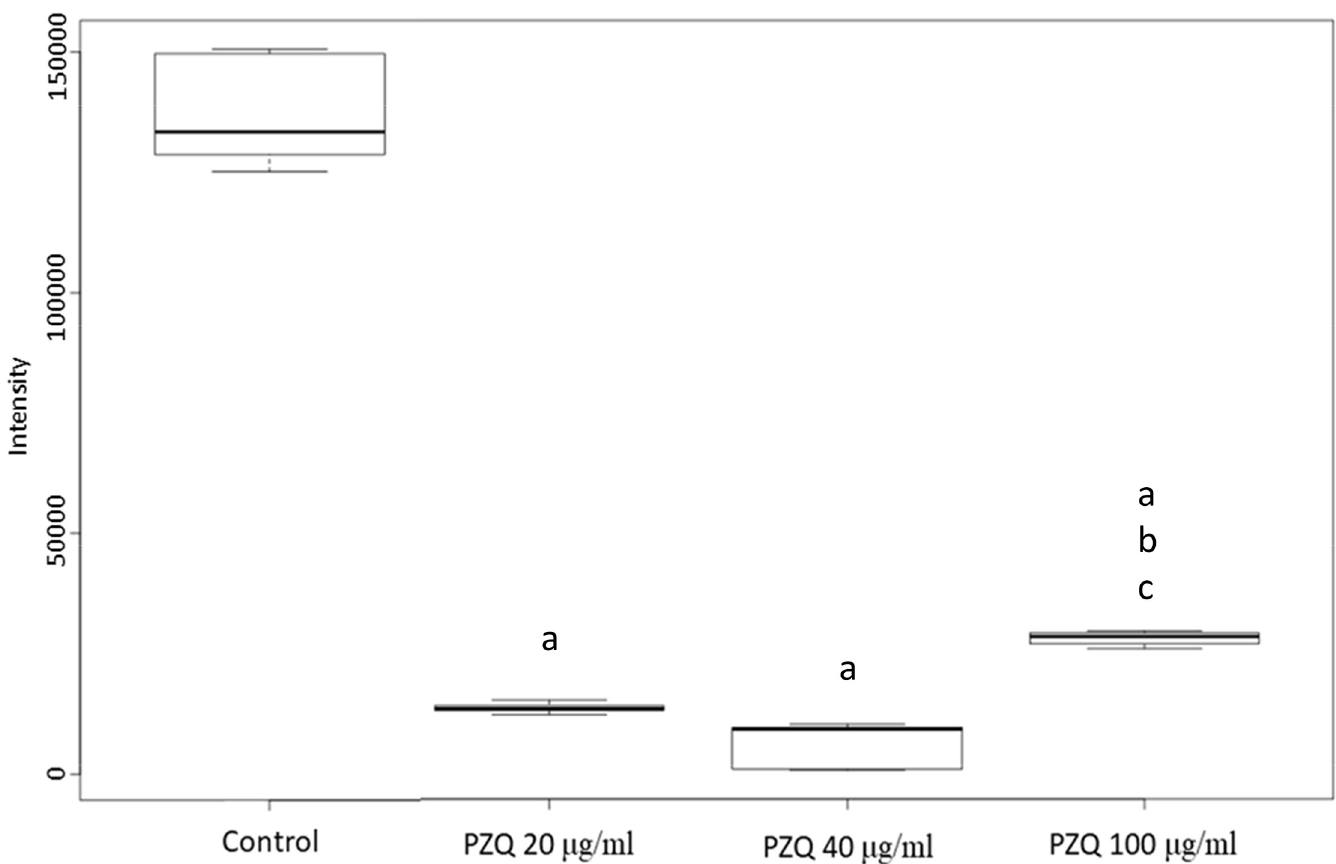
Fig 6. Increased level of PS (14:0/12:0) after different doses of PZQ treatment of S . mekongi . Boxplot shows level of PS (14:0/12:0) following different doses of PZQ. “a” indicates statistical differences at p < 0.01 from control group. “b” indicates statistical differences at p < 0.01 from low dose group. “c” indicates statistical differences at p < 0.01 from medium dose